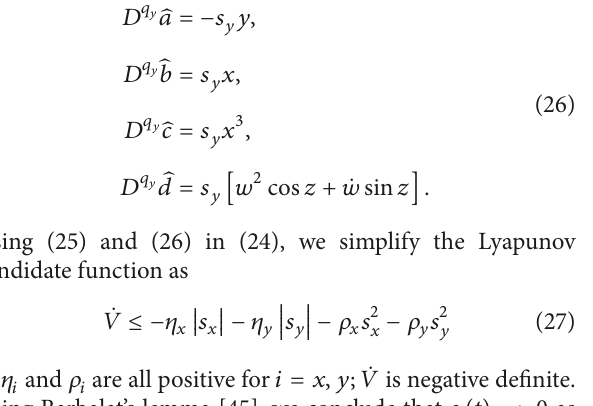
Figure 11: Time history of FOPF parameter estimates (controller in action at 𝑡 = 70